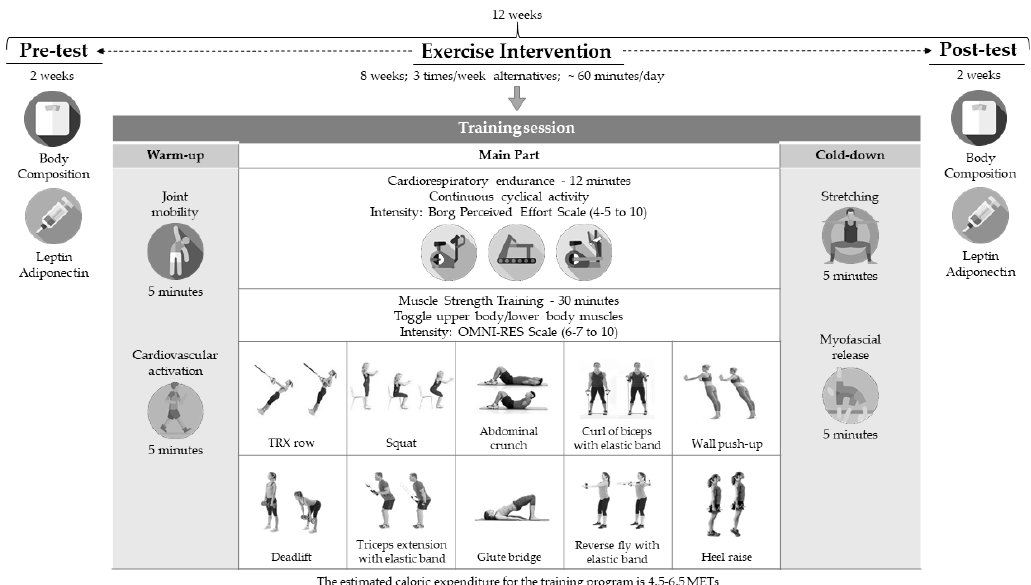
Figure 2. Summary of the training program and training session.